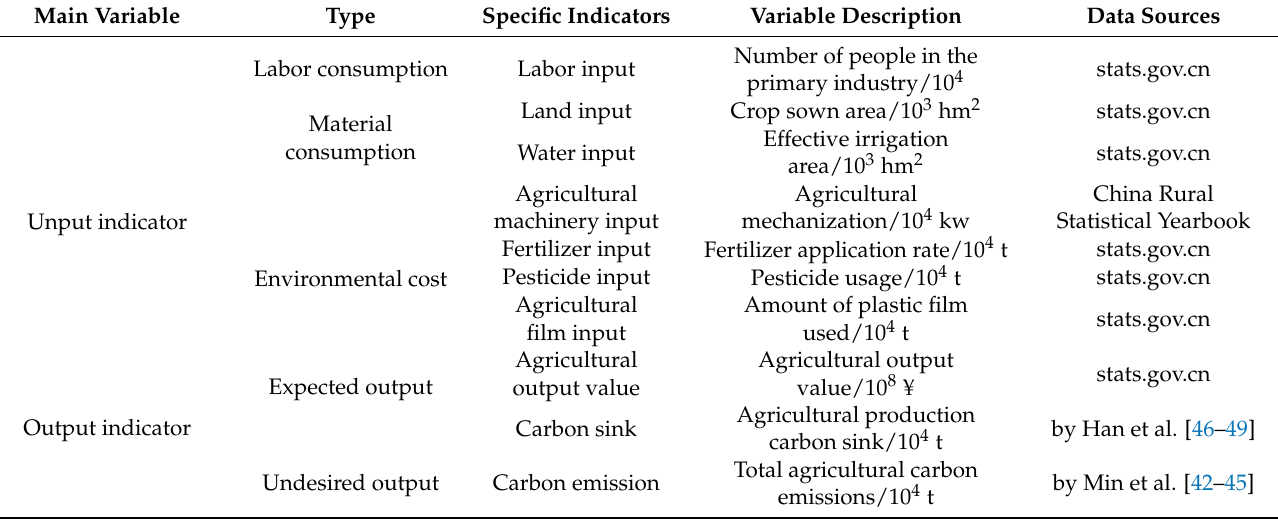
Table 1. Index system of AEE measurement.